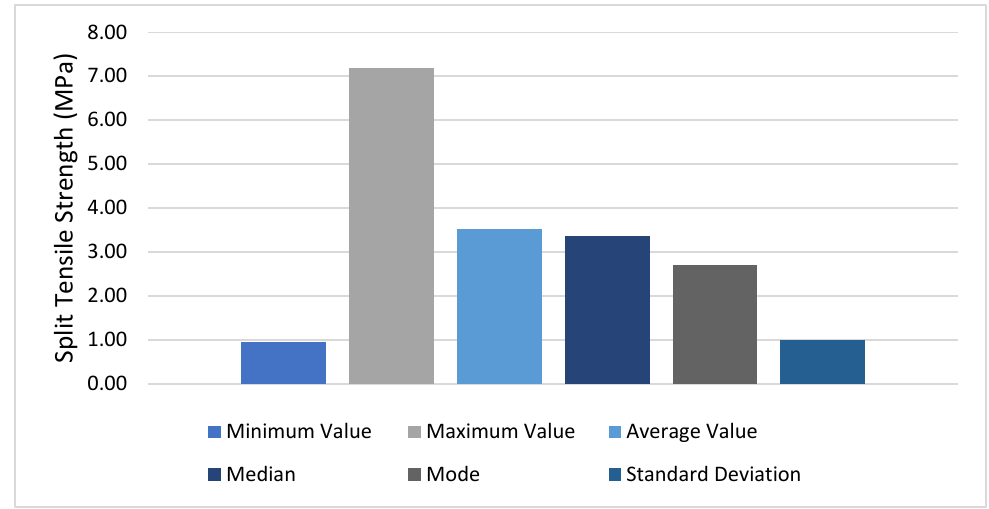
Figure 2. Statistical characteristics of the output variable. Table 2. Statistical characteristics of input and output variables.